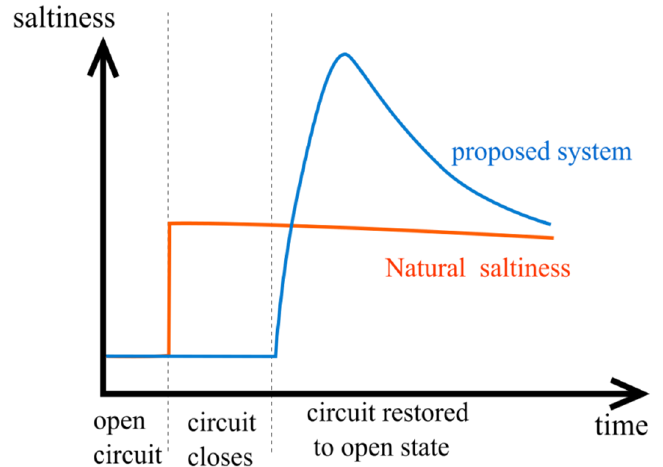
Figure 4. The comparison between salt sensitivity using the natural salt and the electro stimulatory system .